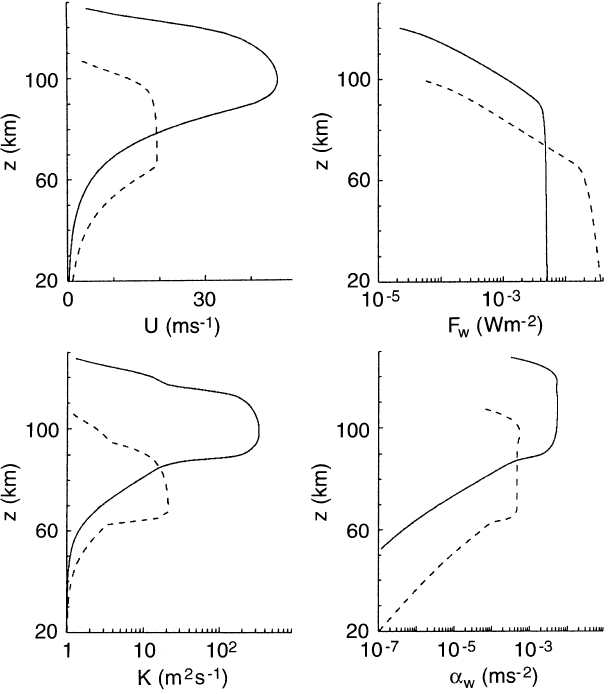
Fig. 2. Vertical profiles of IGW amplitude, U , total vertical energy flux, F w , turbulent viscosity, K , and wave drag, a w , calculated for the same model as Fig. 1, but including constant mean wind u 0 (cid:136) 10m s (cid:255) 1 for the waves propagated in the direction of the mean flow ( dashed lines ), and opposite to it ( solid lines